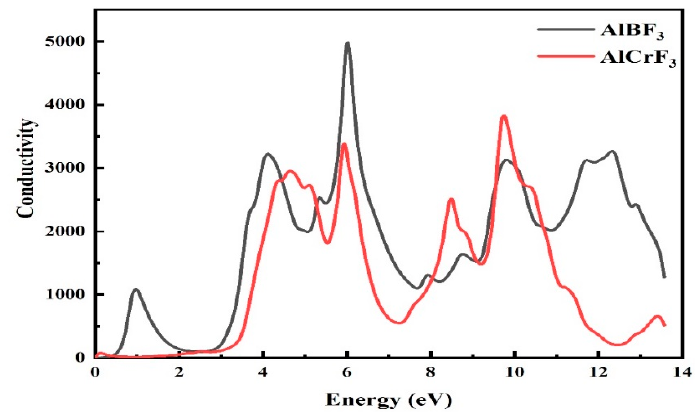
Figure 5. Figure represents the conductivity of the given AlMF 3 compounds (M = Cr, B).